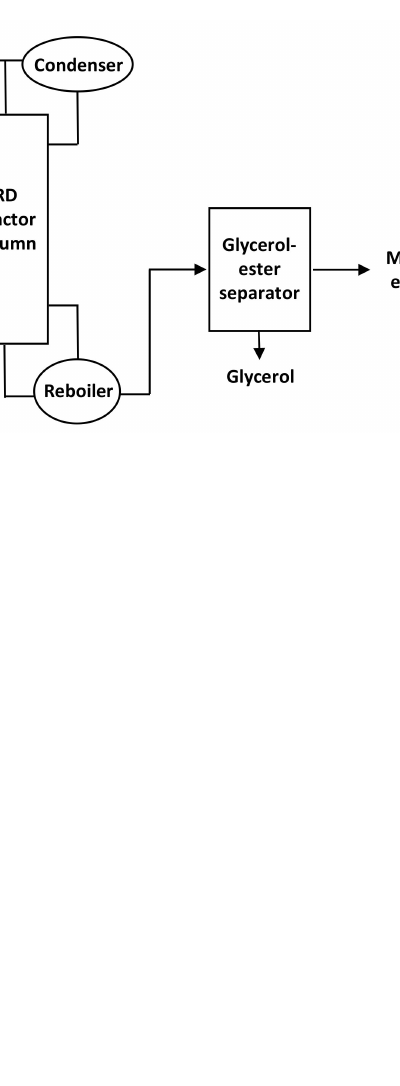
Figure 14. Static mixer closed-loop system.